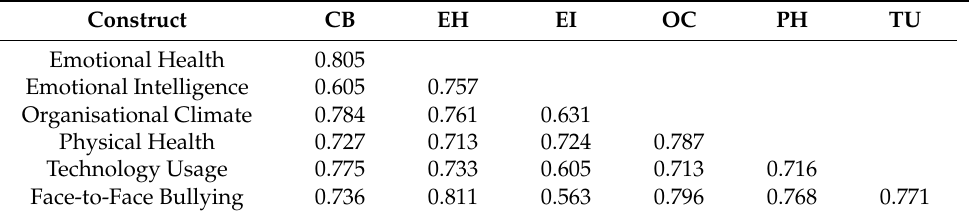
Table 3. Heterotrait-monotrait (HTMT)